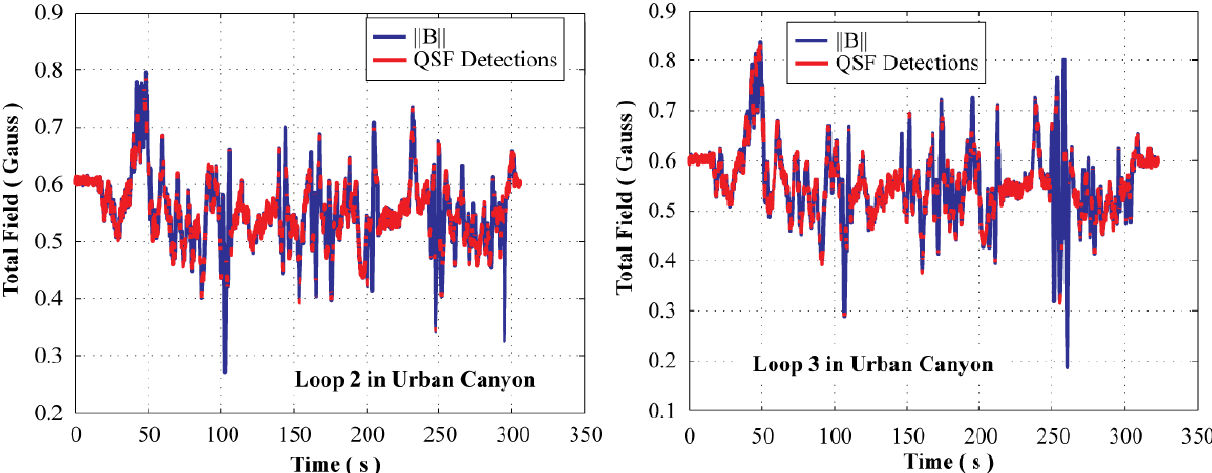
Figure 11. Total field and QSF detections for similar paths in urban